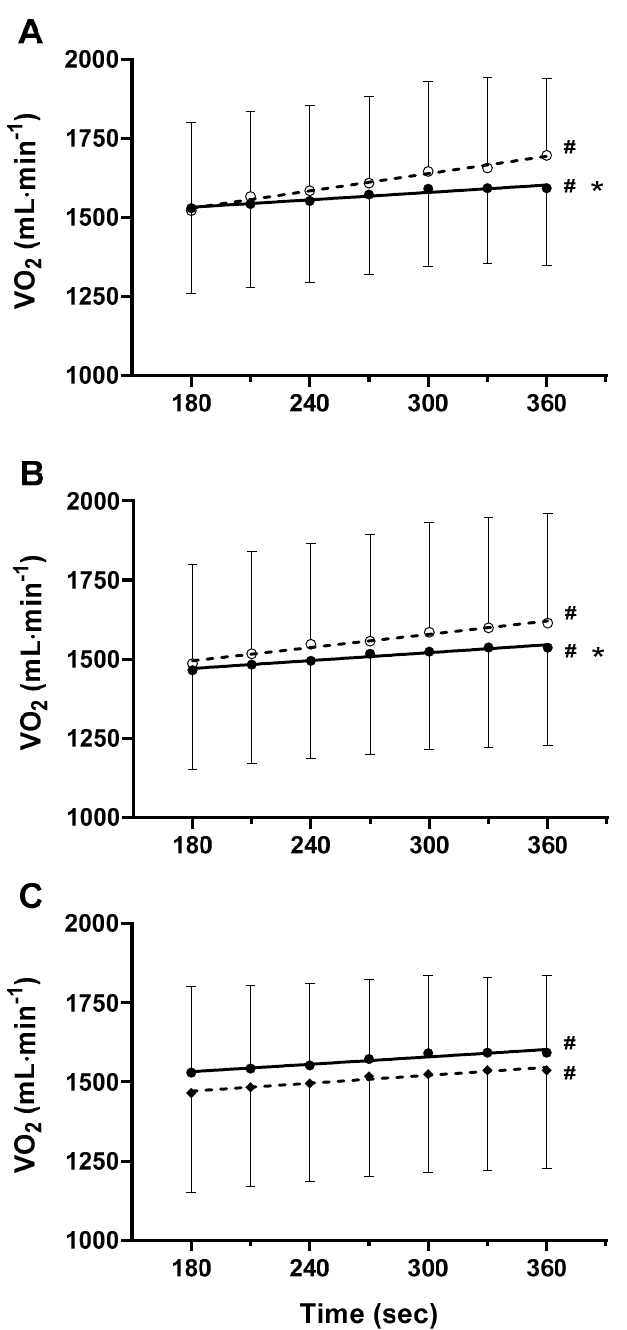
Figure 1. 𝑉(cid:4662) O 2p vs. time from the 3rd to 6th min of exercise during DL-HVY. Data show the linear increase of 𝑉(cid:4662) O 2p vs. time before (PRE, empty circles) and after training (POST, black points) in SL-ET GRP ( A ) and in DL-ET GRP ( B ). Data in ( C ) refers to the linear increase of 𝑉(cid:4662) O 2p vs. time for SL-ET GRP (black circles) and for DL-ET GRP (black diamond) at POST. Data are expressed as mean ± standard deviation. #: angular coefficient of the regression line is significantly different from zero. *: angular coefficient of the regression line is significantly different between PRE and POST.